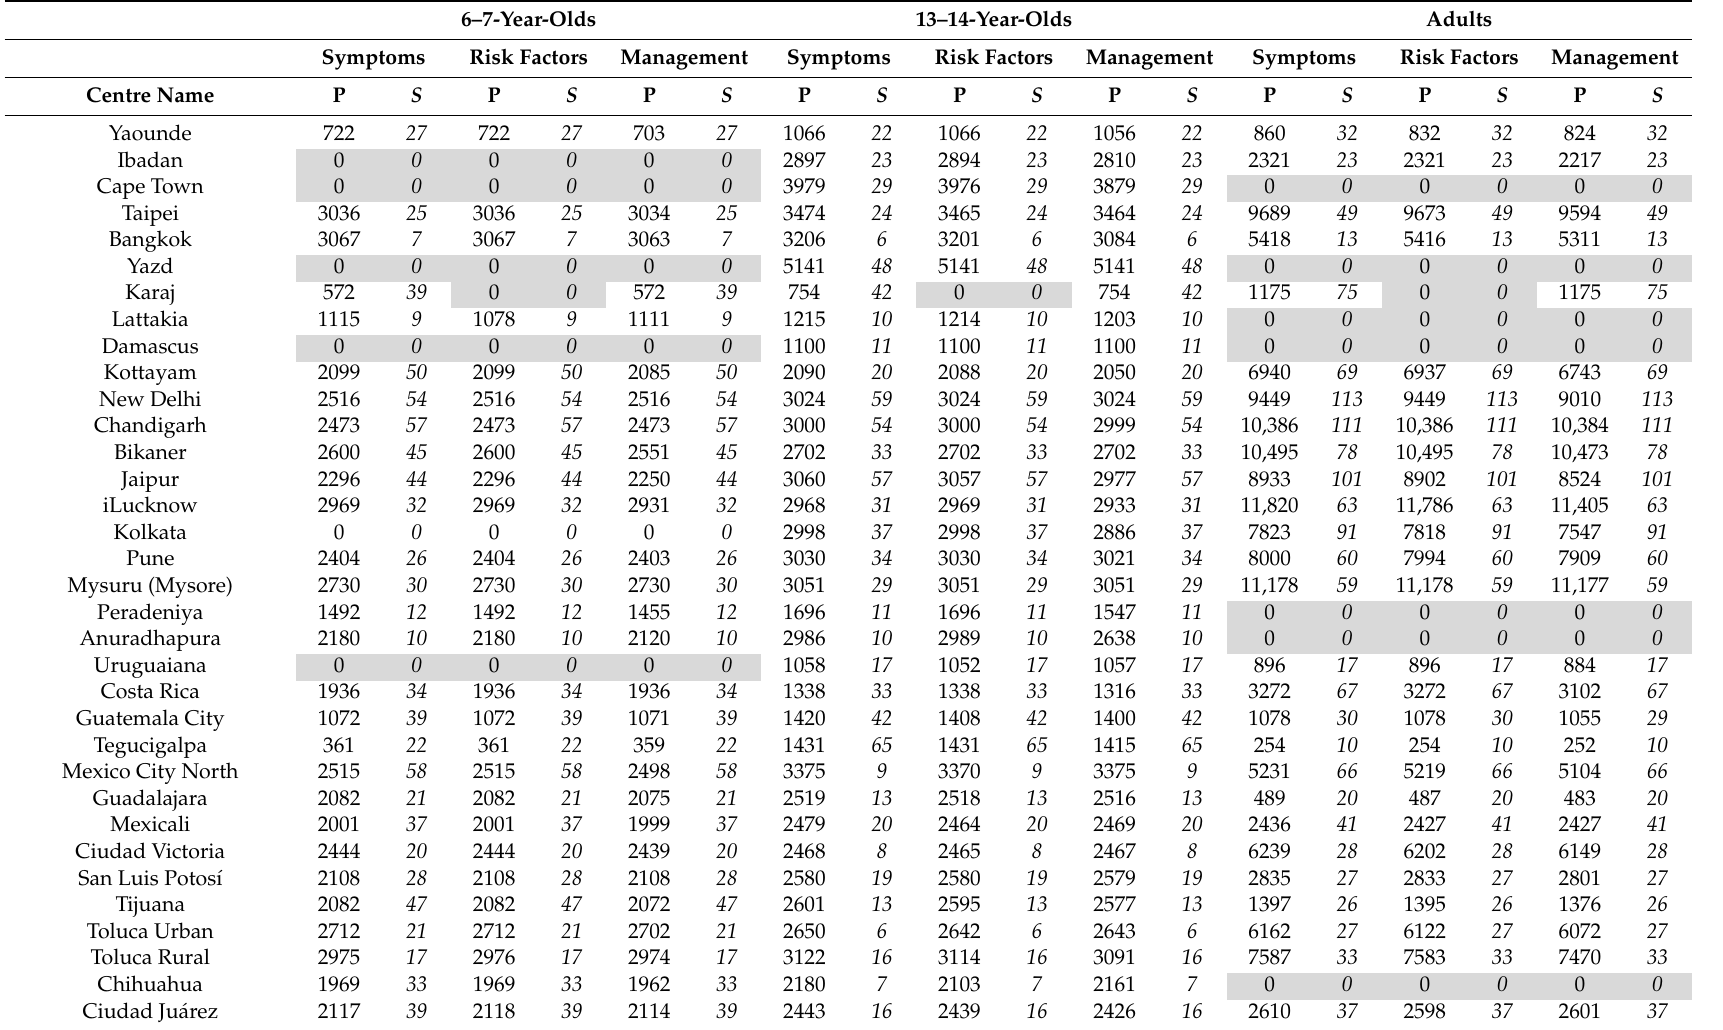
Table 2. Number of participants (P) and number of schools (S) responding to each GAN module by study centre and